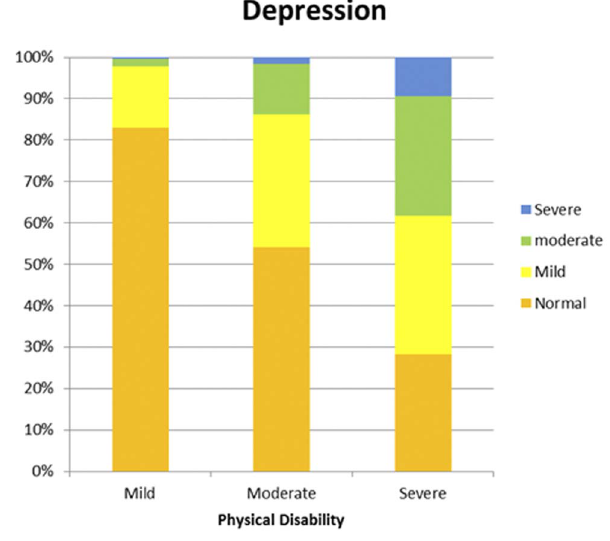
Figure 1. The proportions of people with low, moderate or high physical disability experiencing anxiety. The proportions of people reporting normal ( , =7), mild (8–11), moderate (12–15) or severe ( . 15) anxiety were assessed against low, moderate and high tertiles of physical disability are shown. It can be seen that greater numbers of the respondents reported symptoms of anxiety with increasing levels of disability. The numbers of people with higher levels of anxiety also increased.